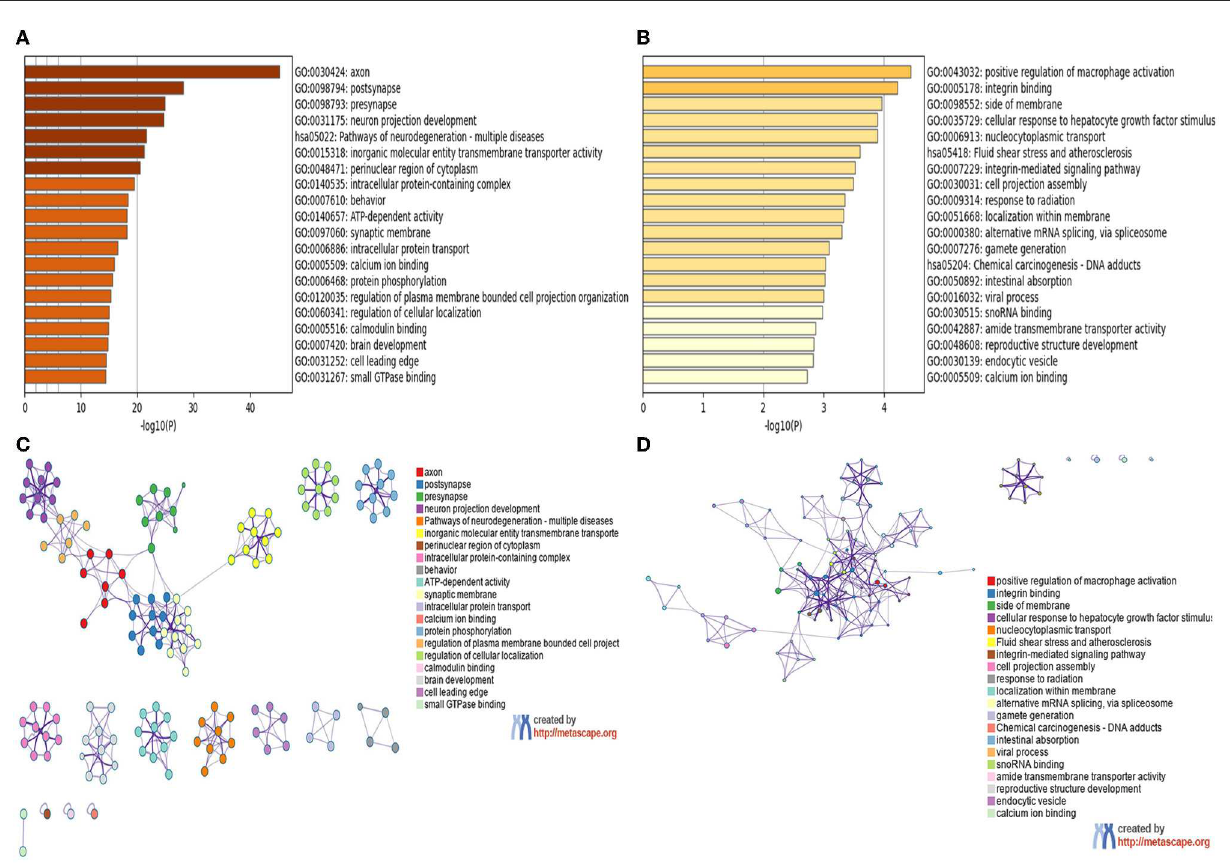
FIGURE5 GO and KEGG enrichment analyses of module genes recognized by the WGCNA analysis. (A) Blue module. (B) Yellow module, bar plots colored by p -values. (C) Blue module. (D) Yellow module, Networks colored by